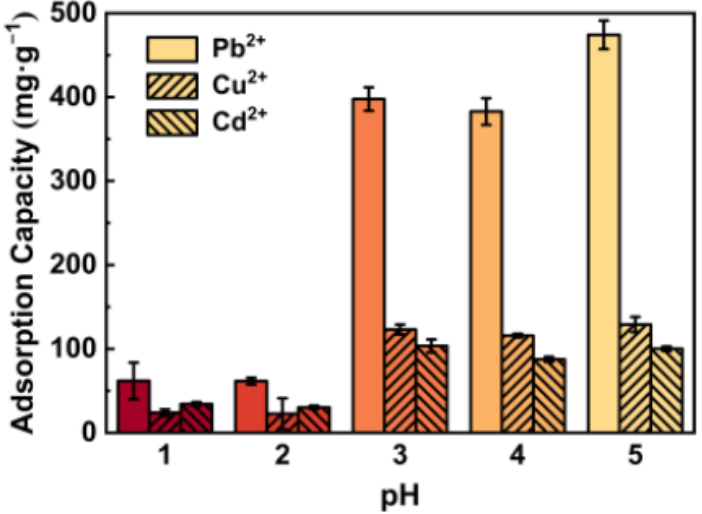
Figure 5. pH effect on the adsorption performance of the composite hydrogel.